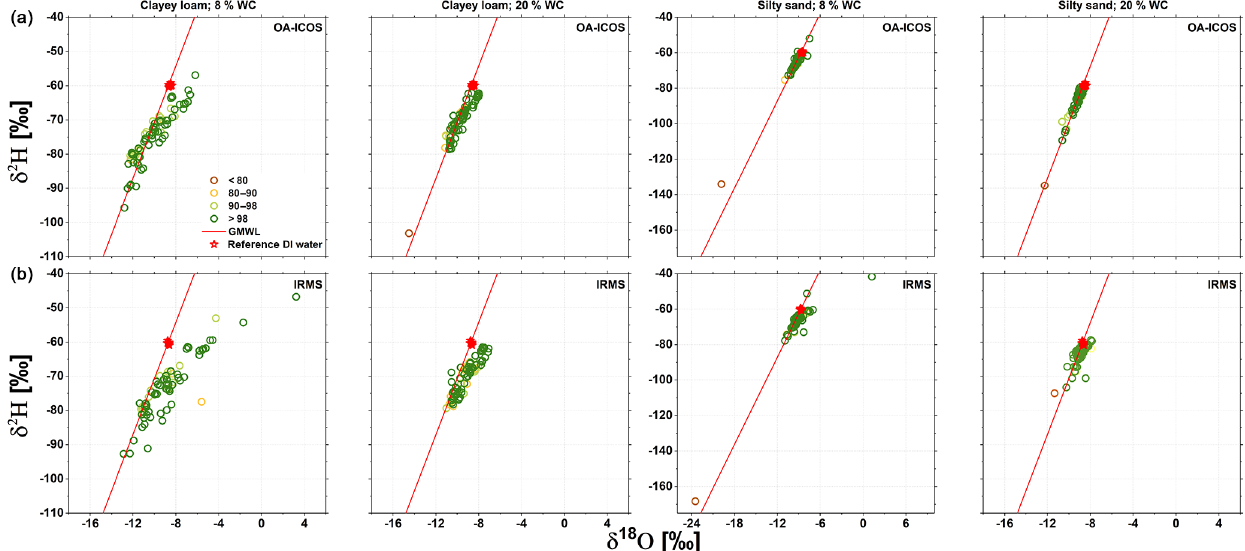
Figure 1. Water recovery rates (grouped from < 80 to > 98%) for both soil types (clayey loam and silty sand), WCs (8 and 20%), and OA-ICOS and IRMS (panels a, b , respectively) isotope data in comparison to the spiked reference DI water (red asterisks) shown in dual isotope space. For reference, plots include the global meteoric water line (GMWL, solid red line). Water recovery rates are shown for those labs that provided the complete set of soil weight data (in % of previously added